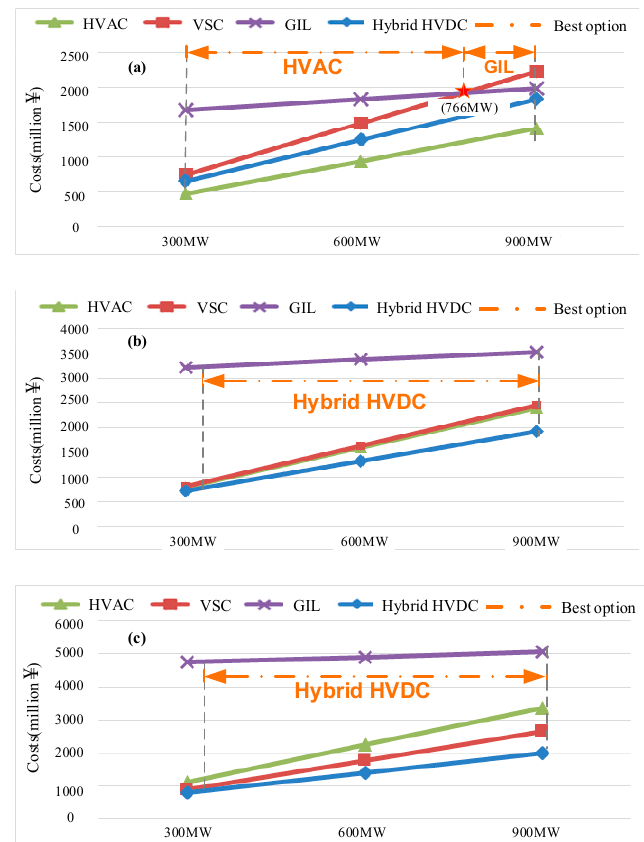
Figure 5. Total costs of different P of 25 km, 50 km, and 75 km wind farms: ( a ) shows the 25 km offshore wind farms total costs with different capacity; ( b ) shows the 50 km offshore wind farms total costs with different capacity; ( c ) shows the 75 km offshore wind farms total costs with different capacity